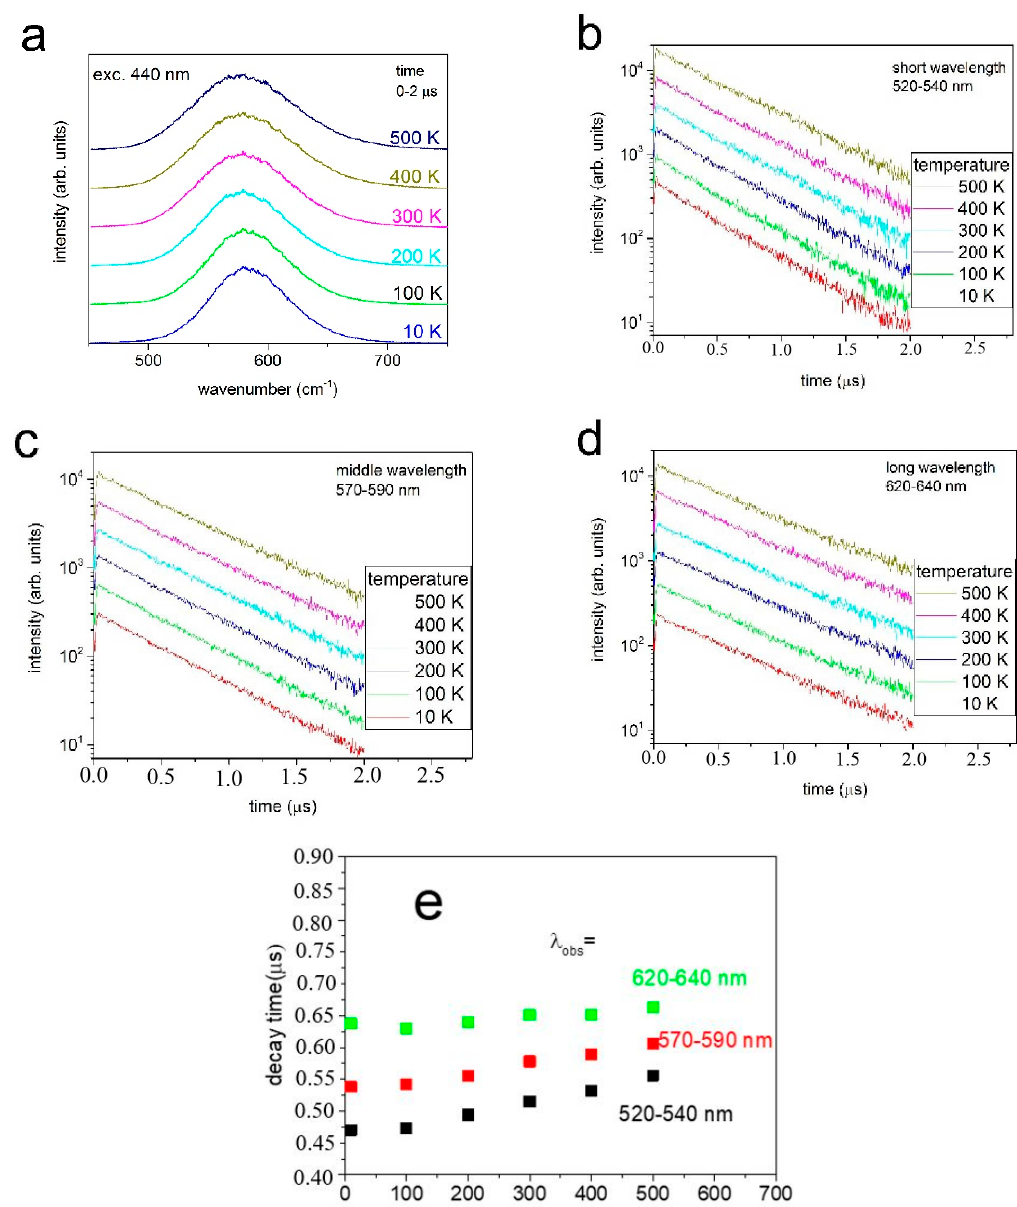
Figure 7. ( a ) Time resolved luminescence spectra of Ca 0.8 Si 9.6 Al 2.4 O 0.8 N 15.2 :Eu 2+ (0.1 mol %) observed in the time range 0–2 µ s, excited with 440 nm at various temperature. ( b – d ) Luminescence decay curves of Ca 0.8 Si 9.6 Al 2.4 O 0.8 N 15.2 Eu 2+ (0.1 mol %,) excited with 440 nm at different temperatures. Luminescence decays are monitored at three region of wavelength ( b ) 520–540 nm ( c ) 530–550 nm and ( d ) 570–590 ( e ) Decay times calculated by single exponential fit of decay profiles for the selected region of luminescence wavelength.